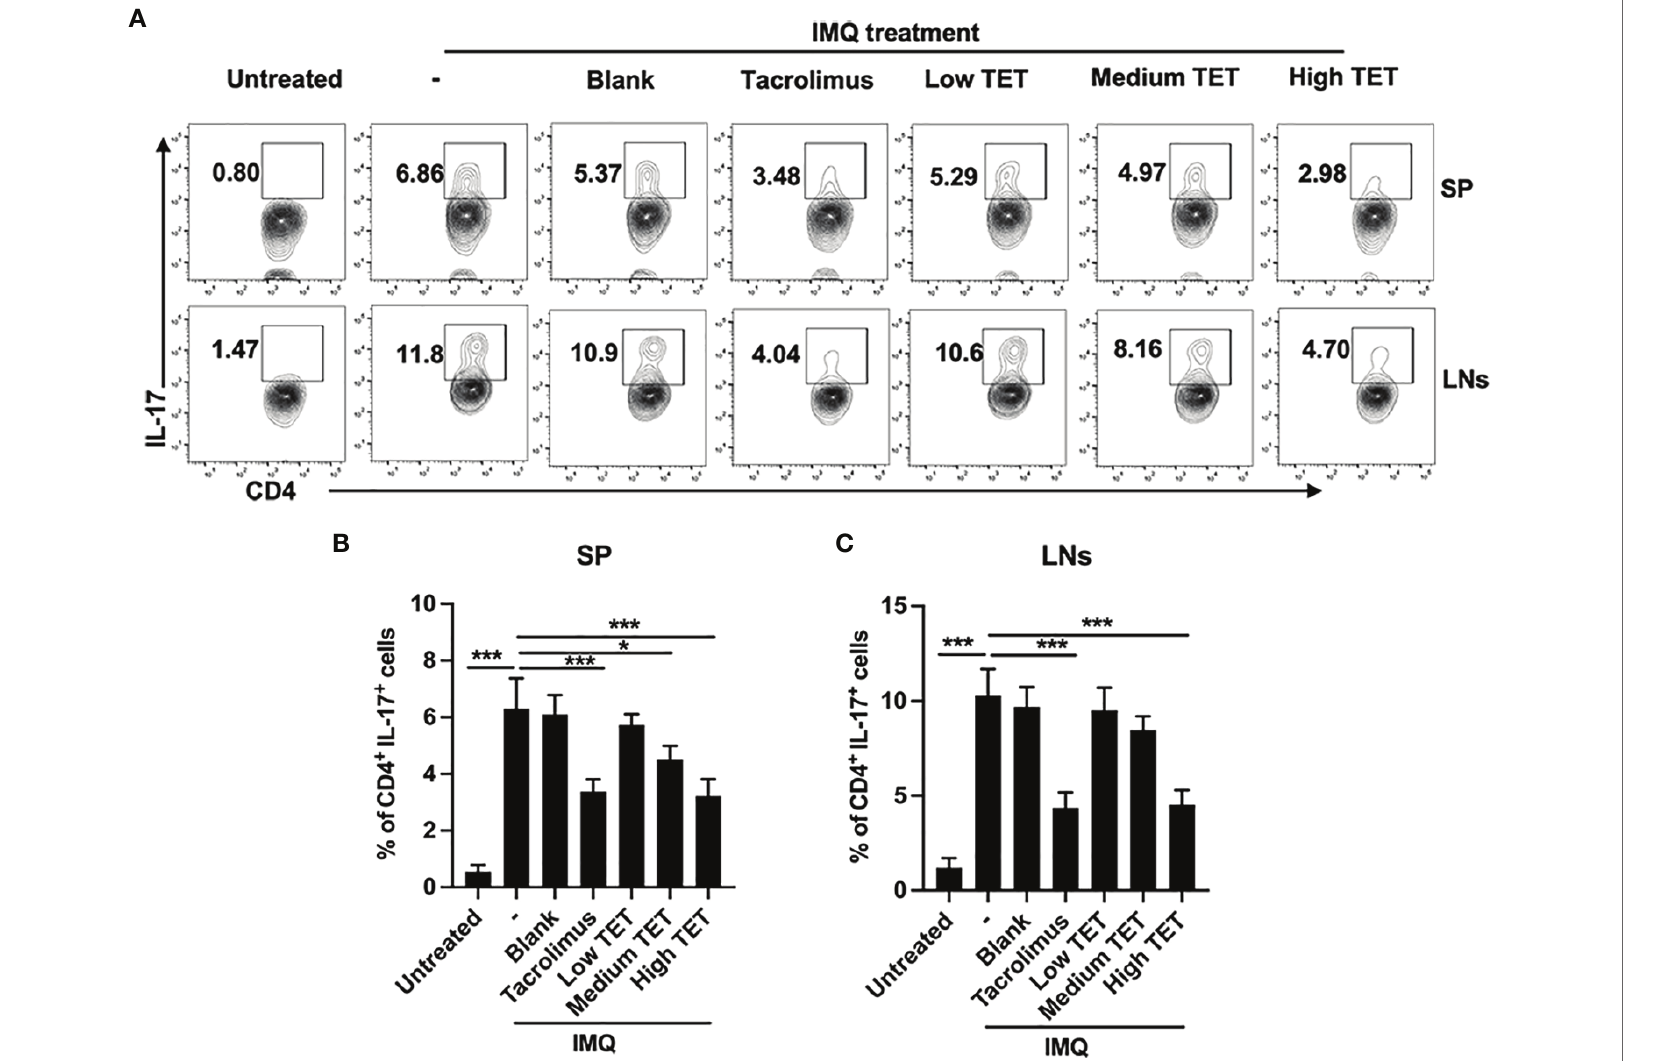
FIGURE 2 | TET NE inhibits in vivo expression of IL-17 in IMQ-treated mice. The C57BL/6 mice (N = 9) were treated with IMQ for 6 days. TET NE treatment starts from the second day after IMQ treatment for 5 days. 24 hours later, the mice were sacri fi ced. Spleens and lymph nodes were harvested. The cells were re-stimulated with PMA and ionomycin in the presence of GolgiPlug for 6 h. Subsets of Th17 cells in CD4 + T cells gate were analyzed by intracellular staining of IL-17A in splenocytes from TET NE- or vehicle-treated psoriasis mice. FCM then analyzed the proportion of the Th17 subset in CD4 + T cells. (A) Representative FACS data are shown. The number in the FACS data indicates the proportion of gated cells. (B, C) show summarized data. Data were shown as means ± SEM. -: IMQ without treatment; Blank: IMQ + blank gel treatment. * P < 0.05, *** P < 0.001, compared with IMQ group (denoted as